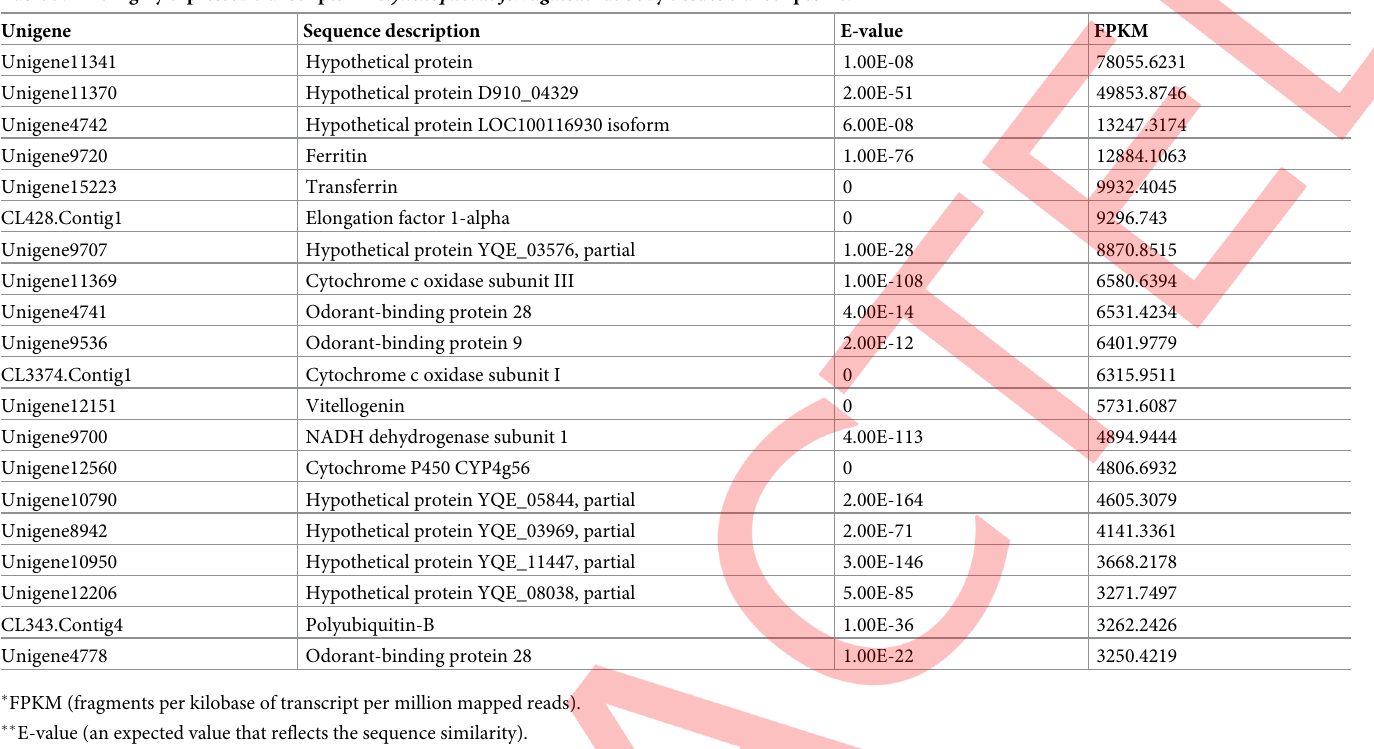
Table 7. The highly expressed transcripts in Rhynchophorus ferrugineus fat body tissues transcriptome.